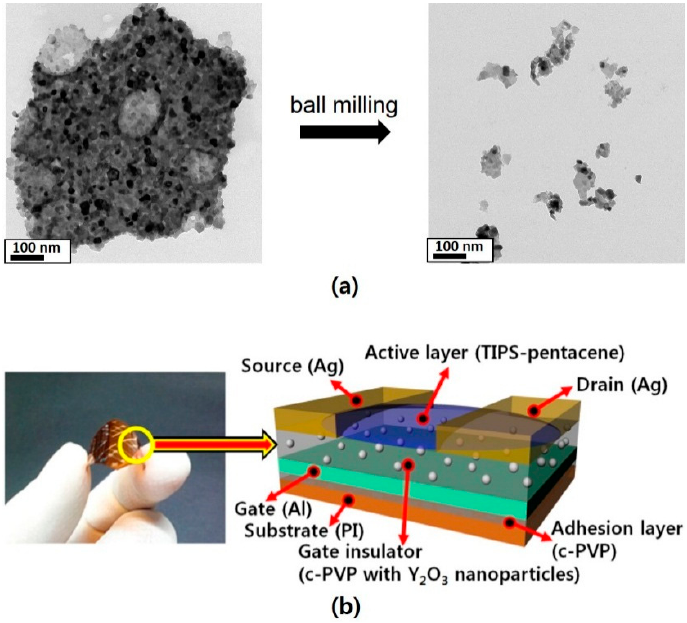
Figure 1. ( a ) TEM images of Y 2 O 3 particles; ( b ) Schematic of the fabricated flexible TIPS-pentacene TFT.